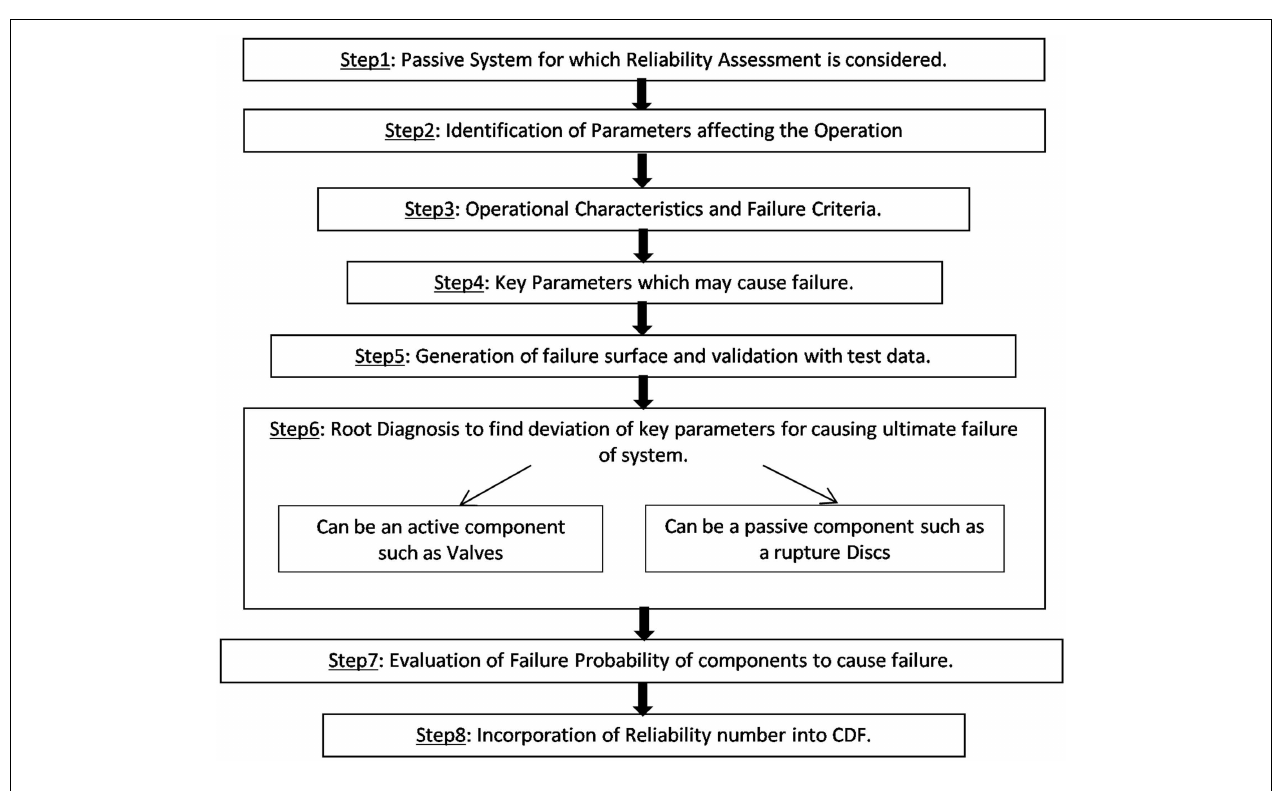
FIGURE 2 |TheAPSRA methodology